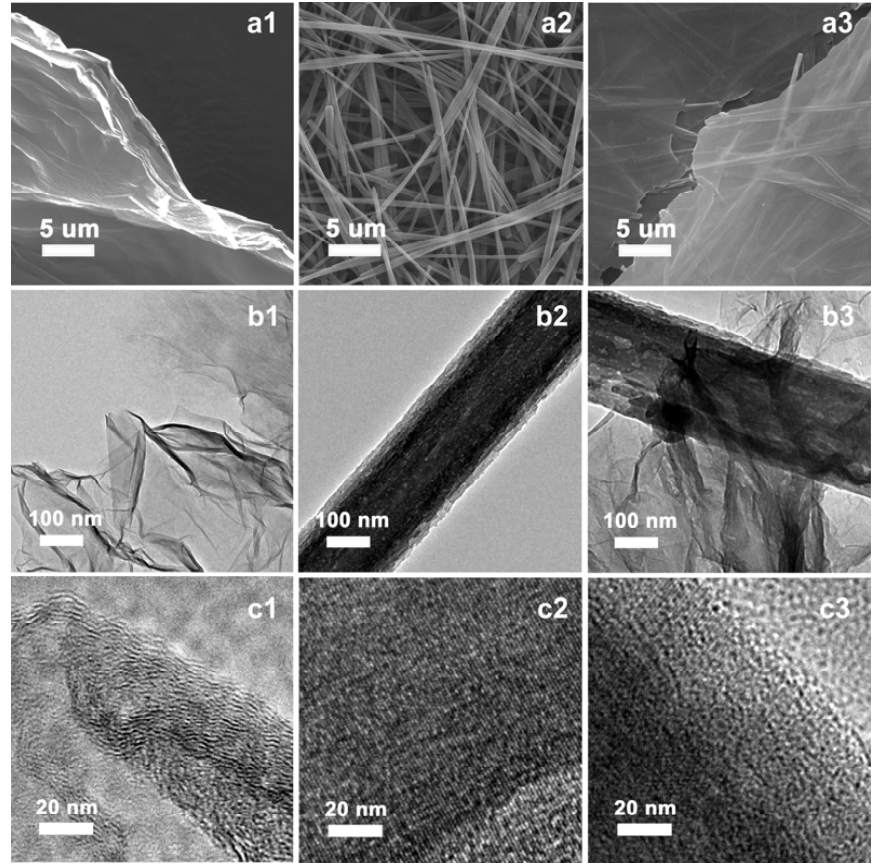
Figure 1. SEM, TEM, and HR-TEM images of GO ( a1 , b1 , c1 ), FCFs ( a2 , b2 , c2 ), and FCFs@GO ( a3 , b3 , c3 ).